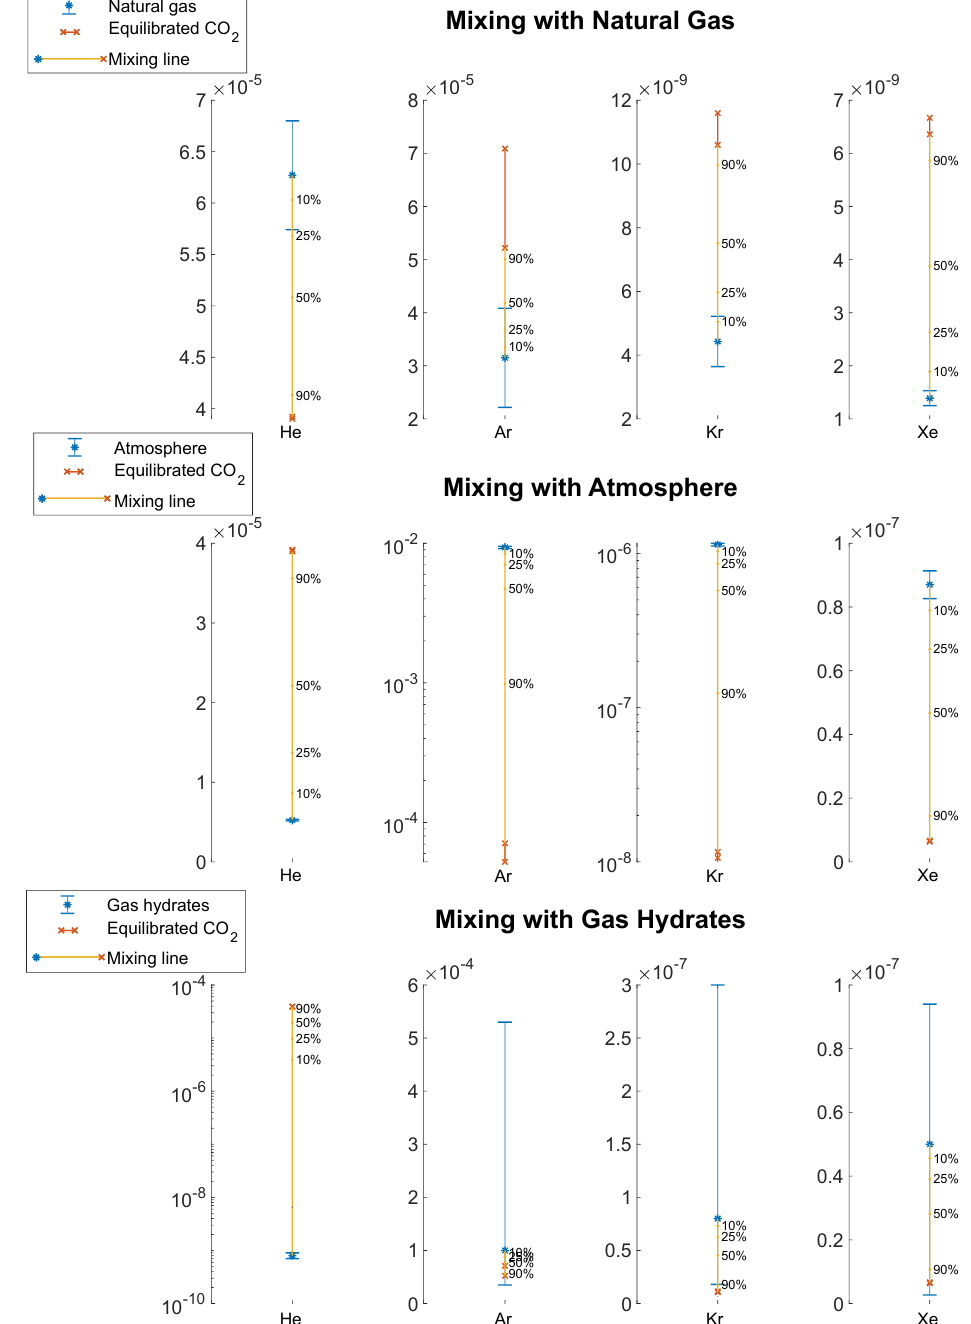
Figure 2. Mixing of the equilibrated CO 2 with background concentrations in natural gas, atmosphere, and gas hydrates in (cm 3 /cm 3 ). For seawater, gas-specific solubilities have to be applied. STP STP The range of equilibrated CO 2 is the orange line, with the values as stated in Table 3. Mixing is calculated for the lower of these values. Background concentrations are shown with error bars (blue)—being dominated by the natural variability for natural gas and gas hydrates, and the analytical uncertainty for the